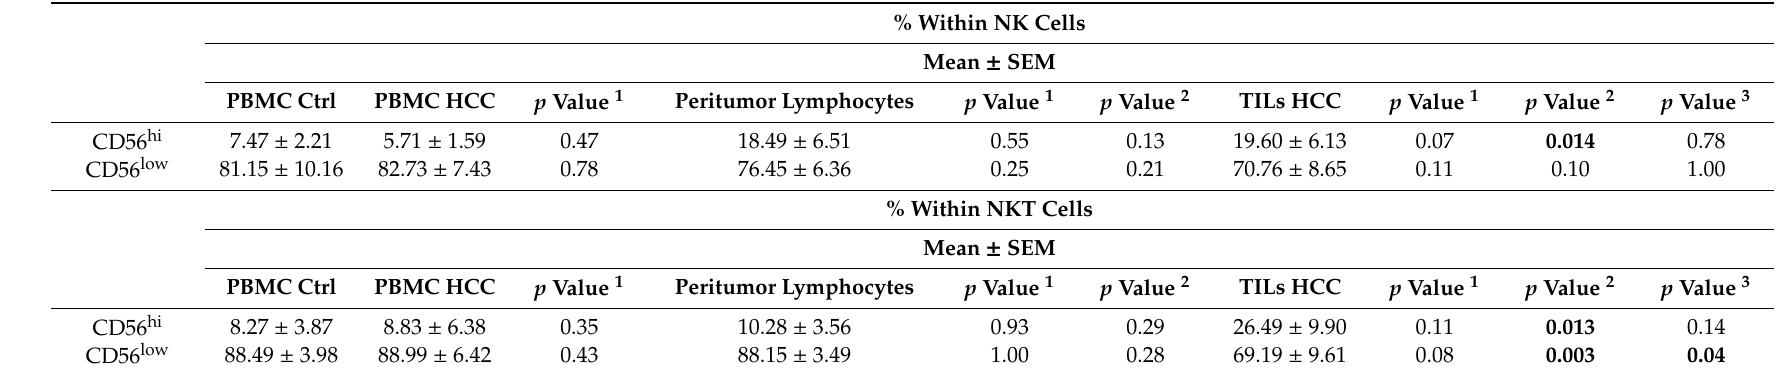
Table 2. NK and NKT